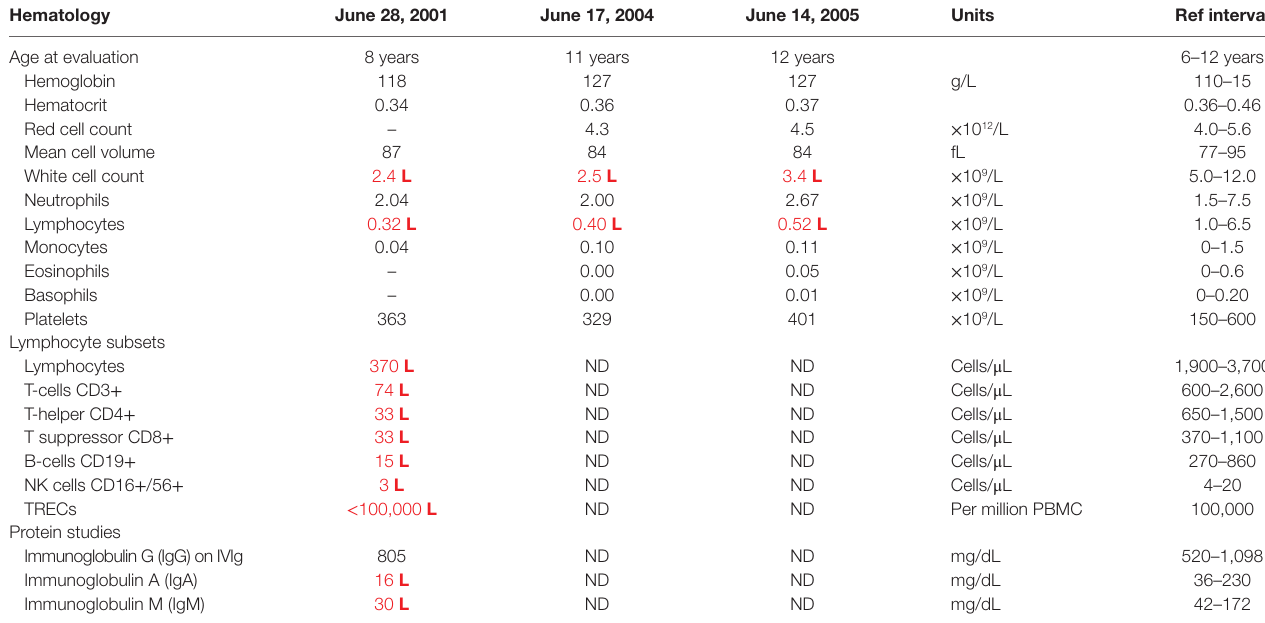
taBLe 1 | Hematology laboratory workup for the